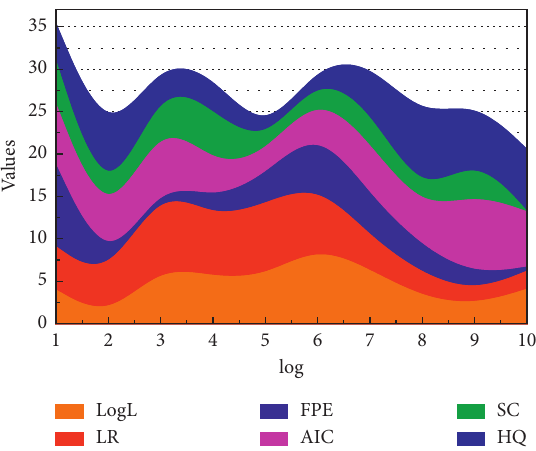
Figure 8: Normal traffic system stimulus information layer: per- ception response layer. Figure